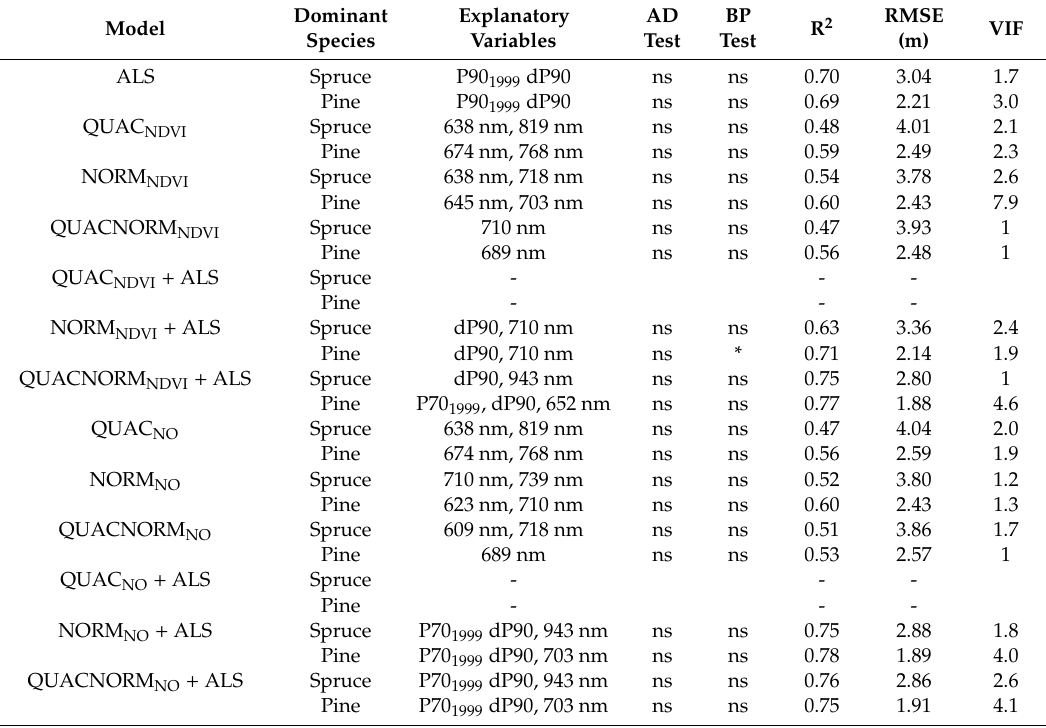
Table 3. Results from modelling the H40 site index using variables derived from either bi-temporal ALS data, hyperspectral data, or a combination of the